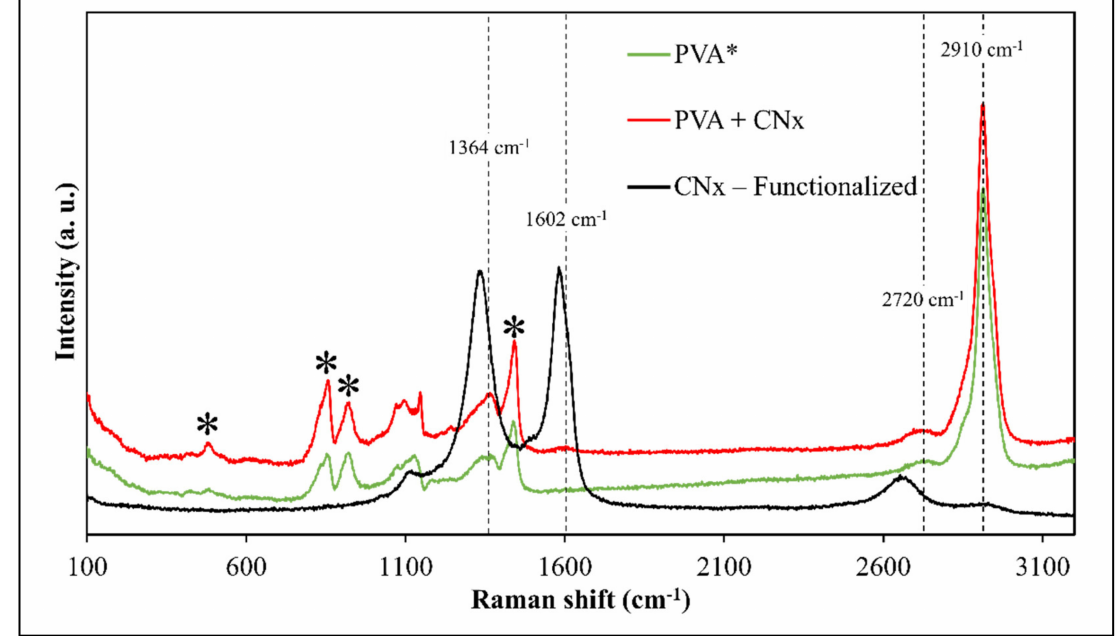
Figure 6. Raman spectra of PVA (green), PVA/CNx/NaDBBS (red), and CNx-functionalized (black). Black asterisks (*) represent the typical signal for